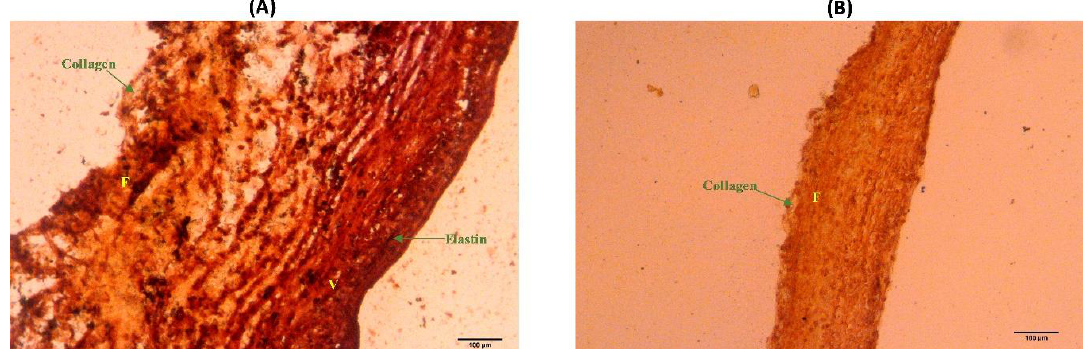
Figure 5. Movat’s staining of: ( A ) Normal native porcine aortic valve non-coronary leaflet and ( B ) elastase-degraded (0.5 mg/ml for 2 hours) native porcine aortic valve non-coronary leaflet. The extracellular matrix (ECM) components stain as brownish-black for Elastin and yellow-orange for Collagen. “F” indicates the fibrosa side and “V” is the ventricularis side of the leaflet. Note that the ventricularis side of the leaflet was completely lost after elastase degradation (B).